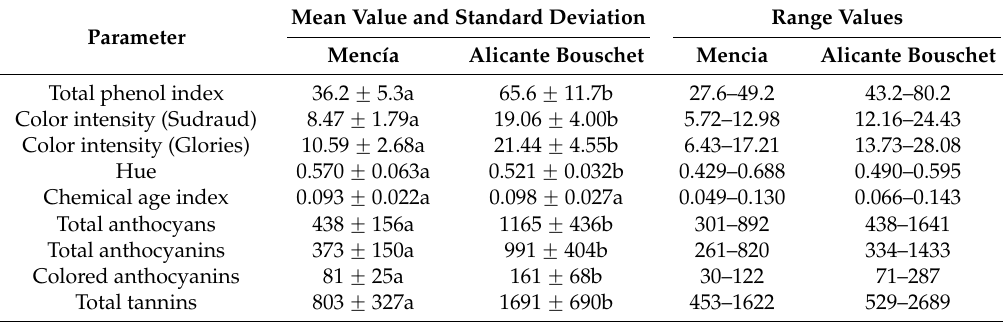
Table 3. Mean values, standard deviations, and range values for analytical parameters related to general phenolic composition and color of young red Mencia and Alicante Bouschet wines. Mean values in the same row followed by a different letter are significantly different ( p <